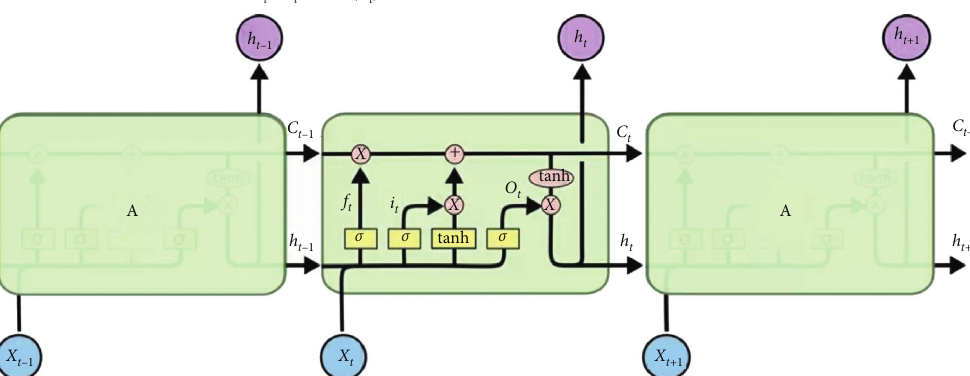
Figure 4: The flowchart of LSTM algorithm [22].